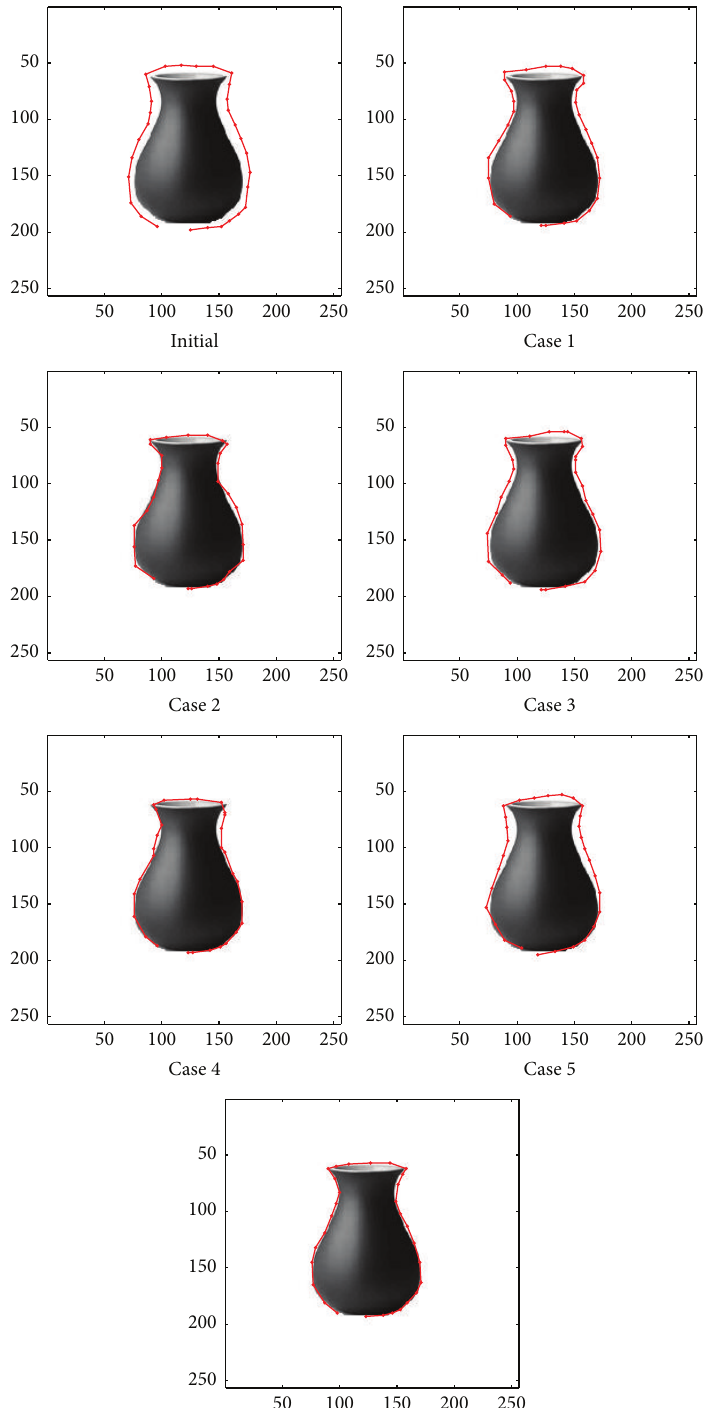
Figure 13: Active contour model implementation by “multipopulation PSO” method for different cases of inertia. Results for “Vase” image with control points = 30, 𝛼 = 0.321 , 𝛽 = 0.054 , and Γ = 0.003